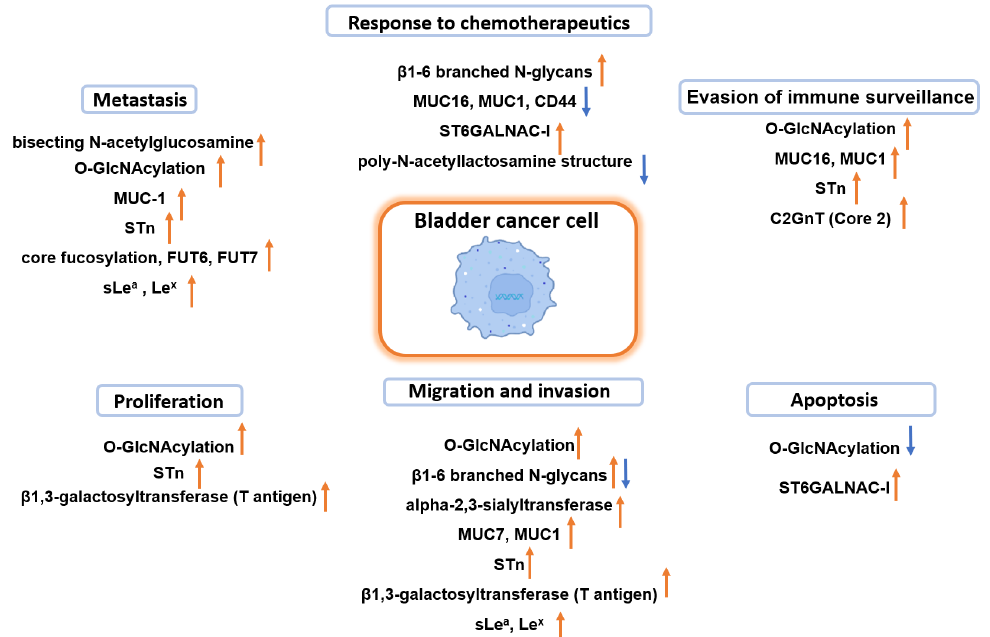
Figure 8. Summarized role of altered glycosylation in bladder cancer progression.